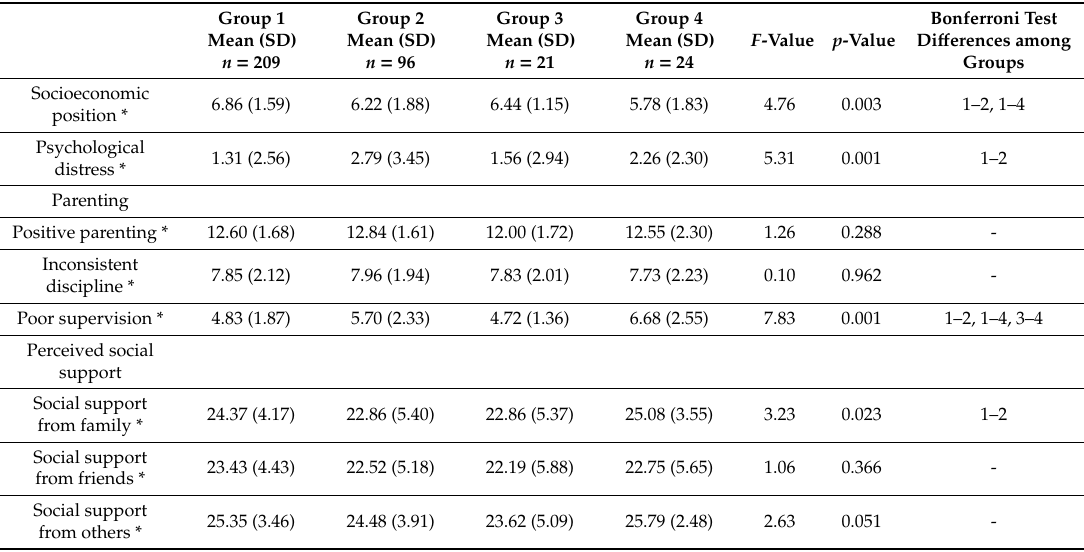
Table 2. Di ff erences among of enrollment / EBP groups regarding parental characteristics: results of one-way analysis of variance and Bonferroni post hoc tests (350 parents and adolescents from the care sample and the community sample, collected in